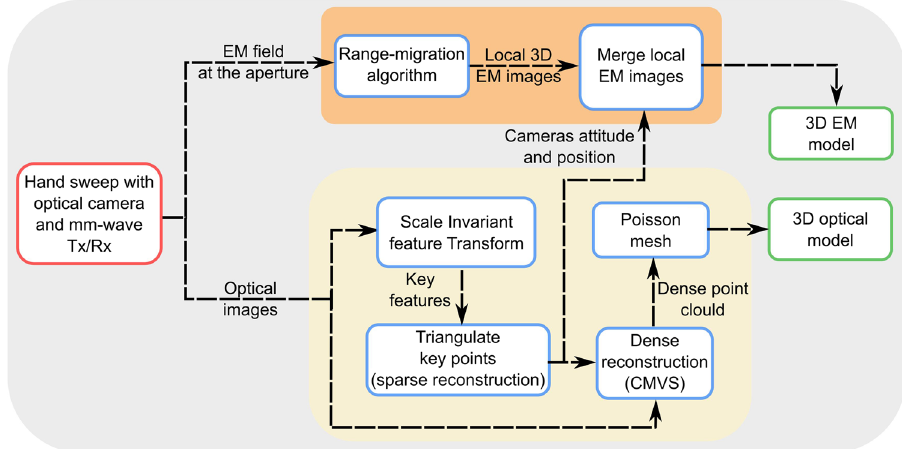
Figure 2. Global diagram combining computer vision techniques with EM imaging.